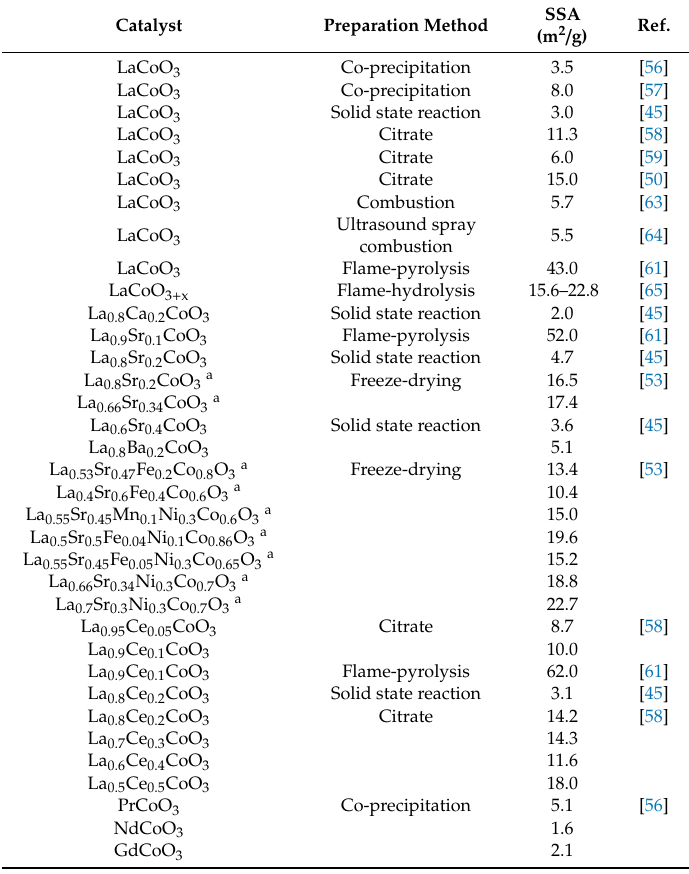
Table 2. The influence of the synthesis method on the specific surface area of di ff erent powder lanthanide cobaltate-based